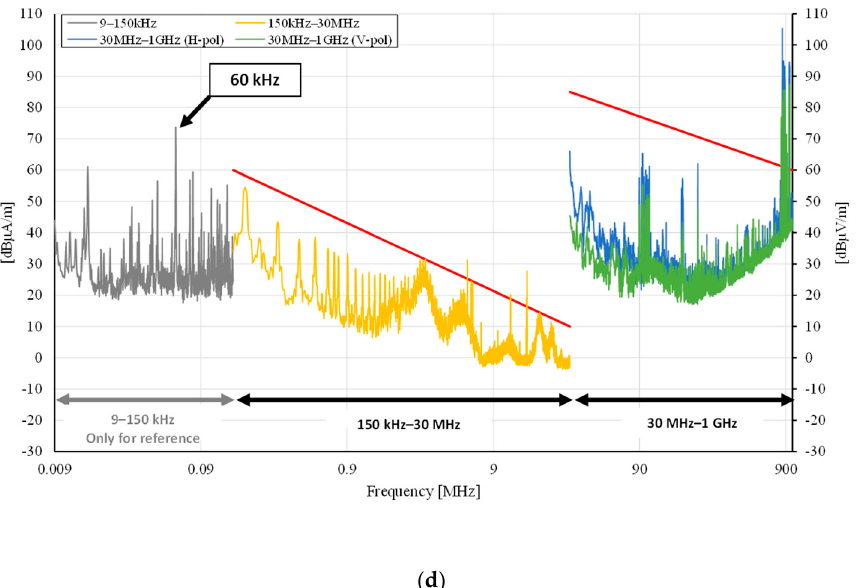
Figure 11. RE measurement results for each scenario: ( a ) without WPT, ( b ) stationary charging, ( c ) dynamic charging: low speed, ( d ) dynamic charging: high speed.